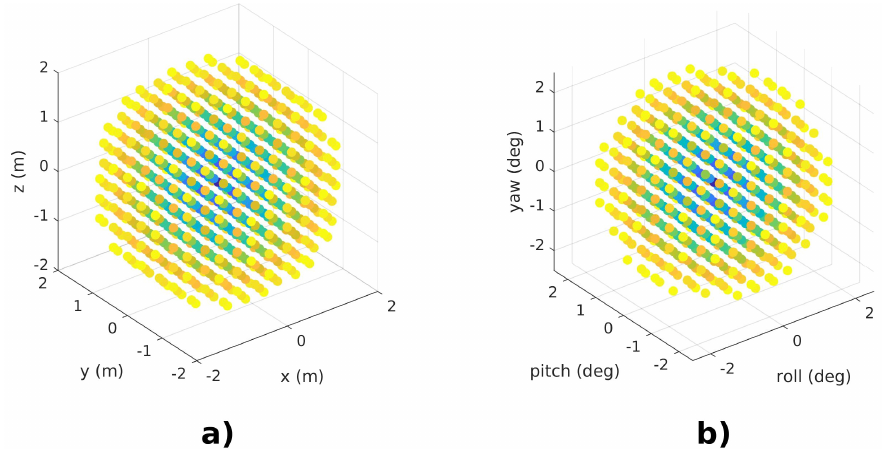
Figure 3. Initial perturbations introduced to ( a ) position states and ( b ) orientation states. Points are colored according to their Euclidean distance with respect to the true displacement, ranging from short distances, marked with blue, to higher distances in